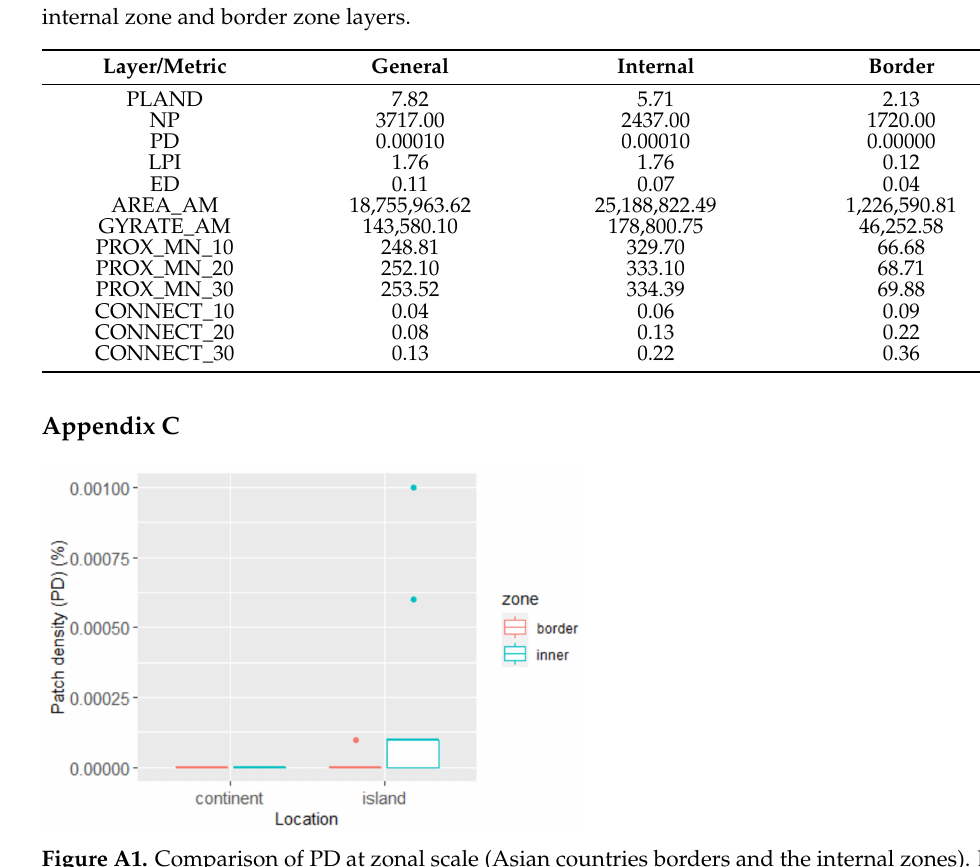
Figure A1. Comparison of PD at zonal scale (Asian countries borders and the internal zones). Dots represent data point that differs significantly from other